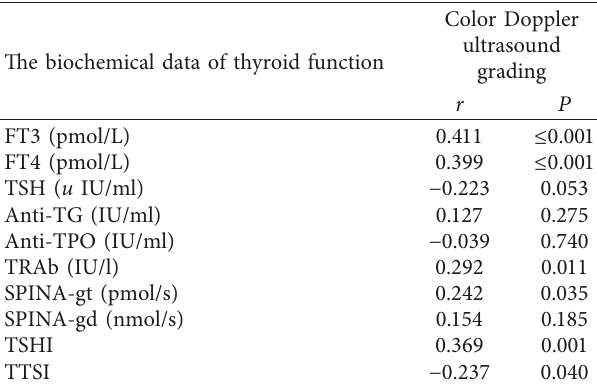
Table 3: Correlation analysis between the color Doppler ultra- sound grading of hyperthyroidism and the biochemical data of thyroid